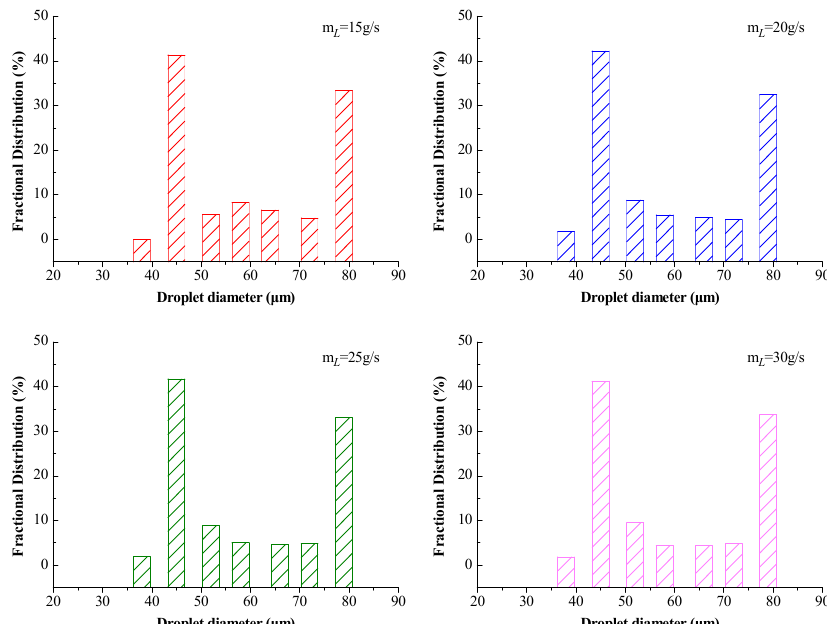
Figure 11. The influence of oil inflow on the oil droplet diameter distribution when the air inflow is 12 g / s, the initial oil droplet diameter is 28 µ m at t = 250